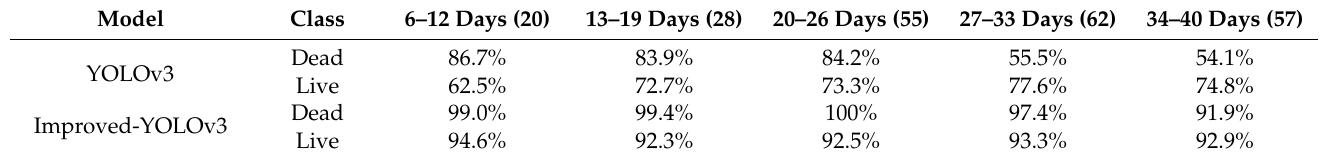
Table 5. Detection performance (AP) in different growth